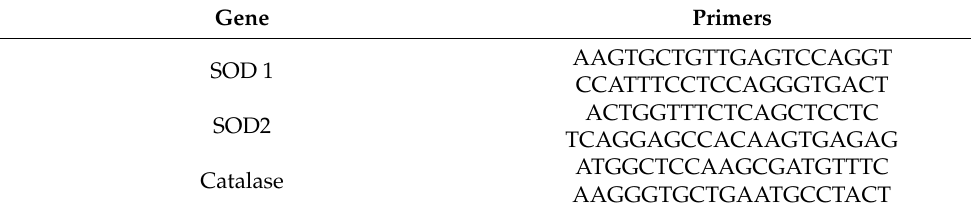
Table 1. Primer sequences used for RT-qPCR.